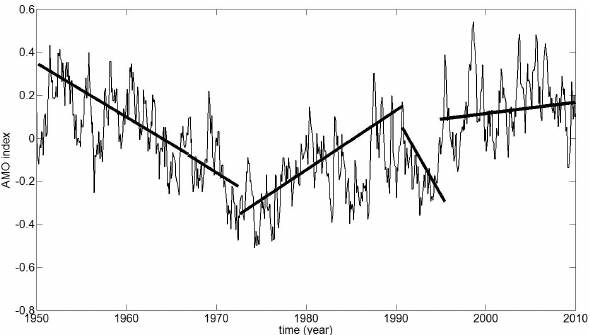
Figure 10. AMO is a pattern of multi-decadal variability in surface temperature centered in the North Atlantic Ocean. The index shows persistent warm and cool phases typically lasting a few decades. The figure shows the AMO index for the period of 1950–2010 and also its linear trends (thick lines).